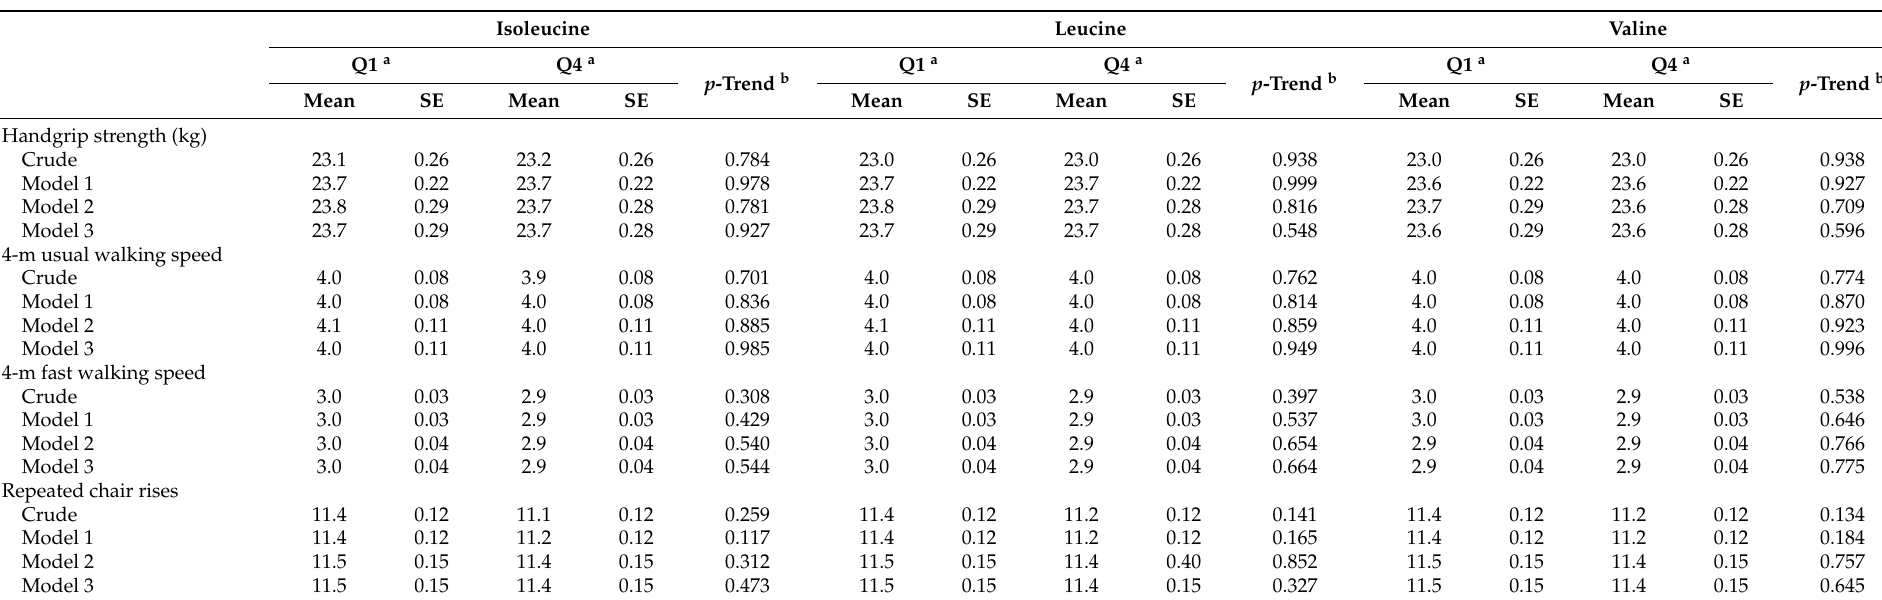
Table 5. Covariate-adjusted mean changes in four physical performance indicators by quartiles of isoleucine, leucine, valine intakes ( n =